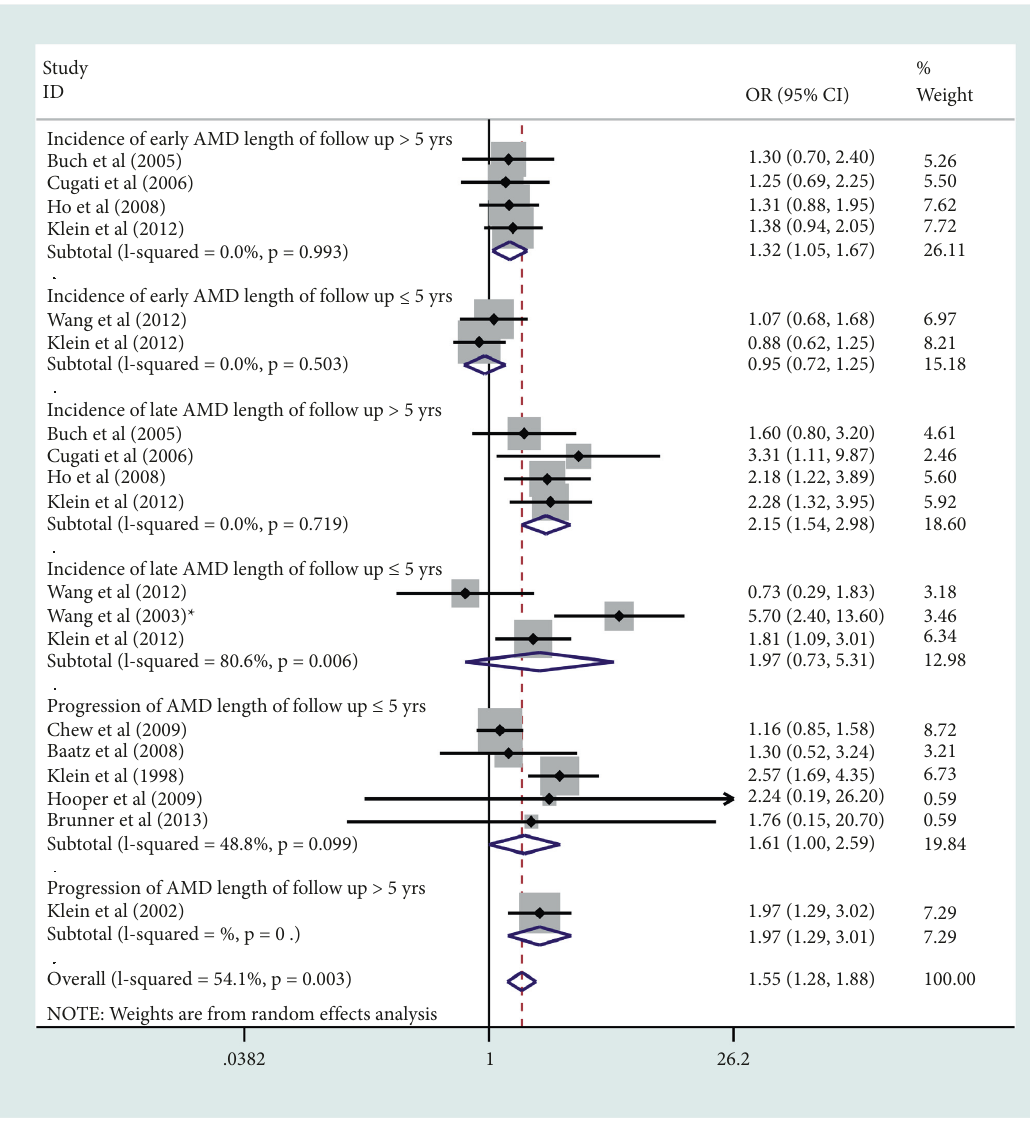
Figure 4: Forest plot evaluating the association between cataract surgery and the development and progression of age-related macular degeneration (AMD) based on follow-up duration. ∗ The result from Blue Mountains Eye Study was included in this subgroup